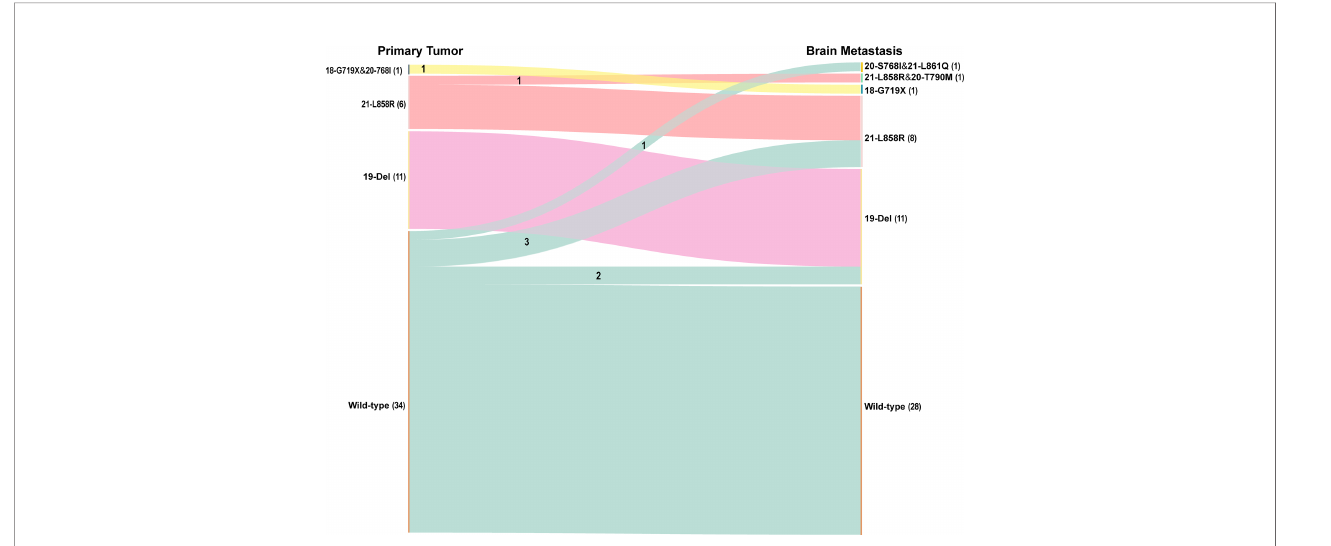
FIGURE 3 | The EGFR mutation status distributions of primary lung cancers and paired metastases Overall, the EGFR status showed a discordance rate of 15.4% between the primary cancer and the matched brain metastases. The number of patients is provided in parentheses. EGFR , epidermal growth factor